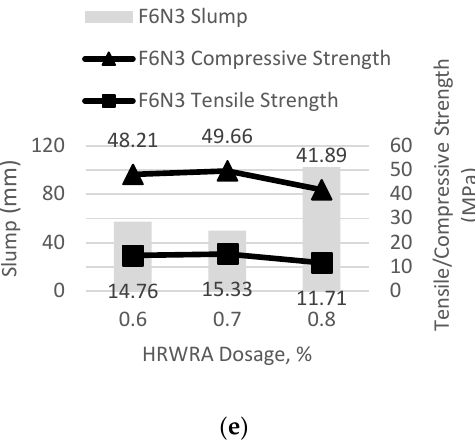
Figure 12. HyFRC dosage requirement (bar chart: slump, line graph: compressive/tensile strength): ( a ) FFC, ( b ) F6U3, ( c ) F6S3, ( d ) F6E3, ( e ) F6N3.